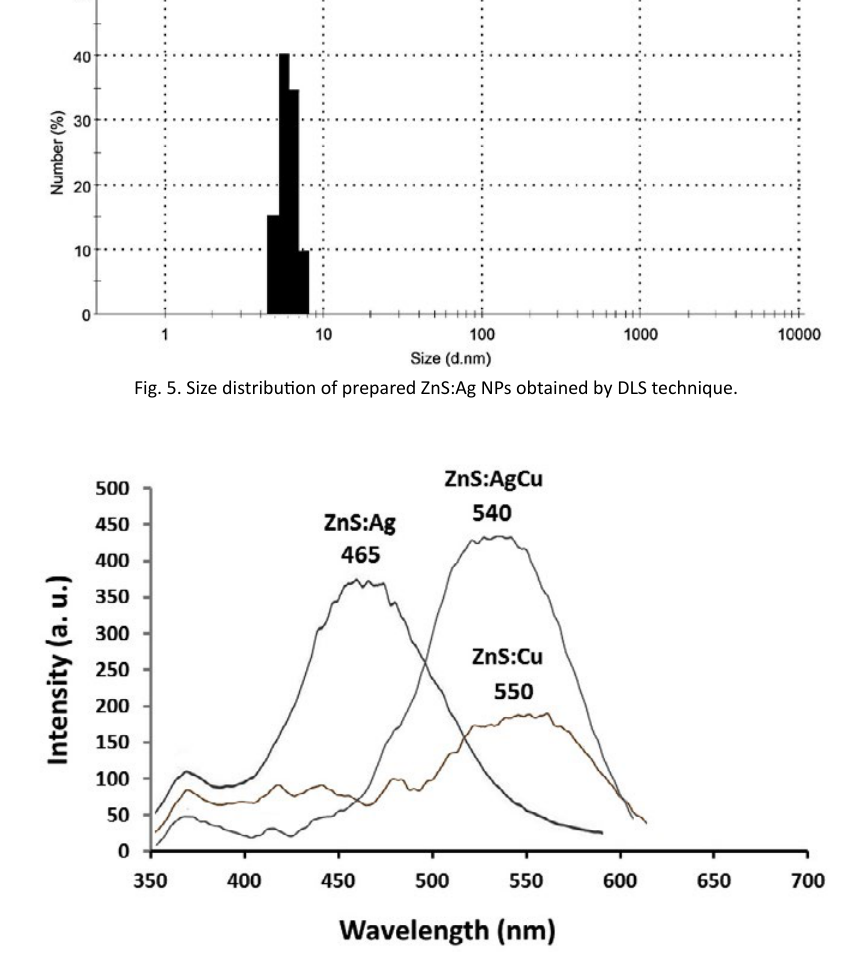
Fig. 6. The PL spectra of ZnS with Ag, Cu and AgCu